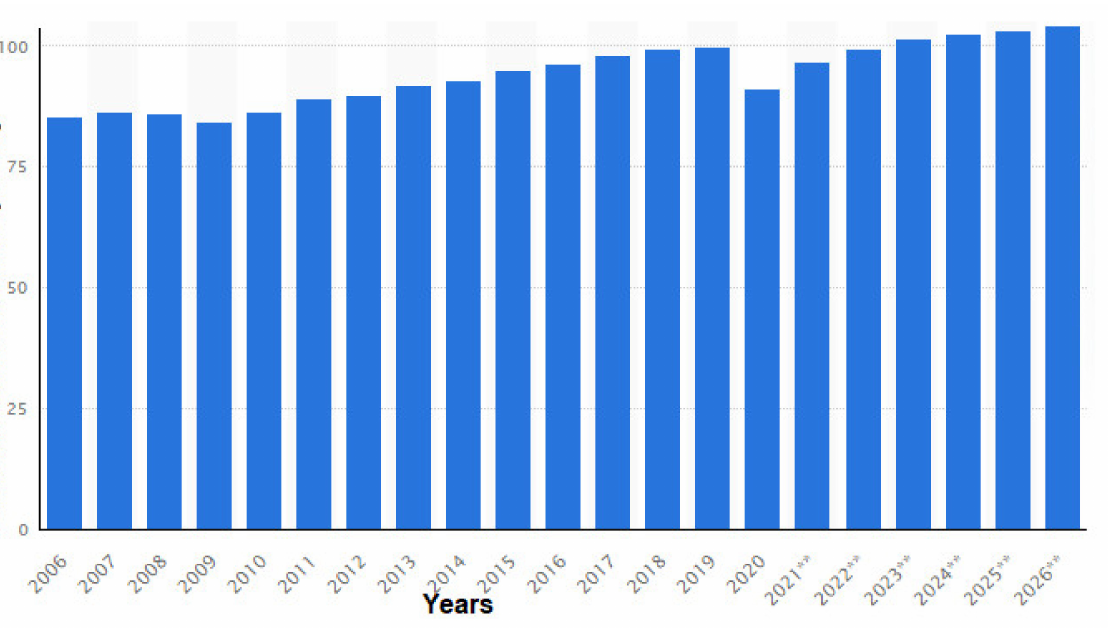
Figure 2. Daily demand for crude oil worldwide from 2006 to 2020, with a forecast until 2026 (in million barrels per day) {** shows the predicted daily demand from the forecast} (Courtesy: IEA & Statista, data retrieved in